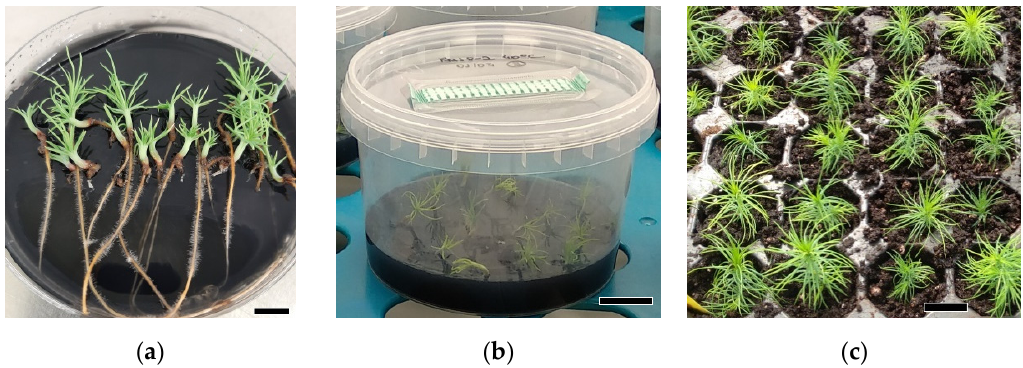
Figure 4. Germination and acclimatization of somatic plantlets from P. radiata obtained from different embryogenic cell lines and maturation temperatures. ( a ) Plantlets after two months in germination medium, bar = 1 cm; ( b ) plantlets after three months cultivated in the germination medium, bar = 2 cm; ( c ) plantlets derived from normal cotyledonary somatic embryos growing in the greenhouse, bar = 2 cm.